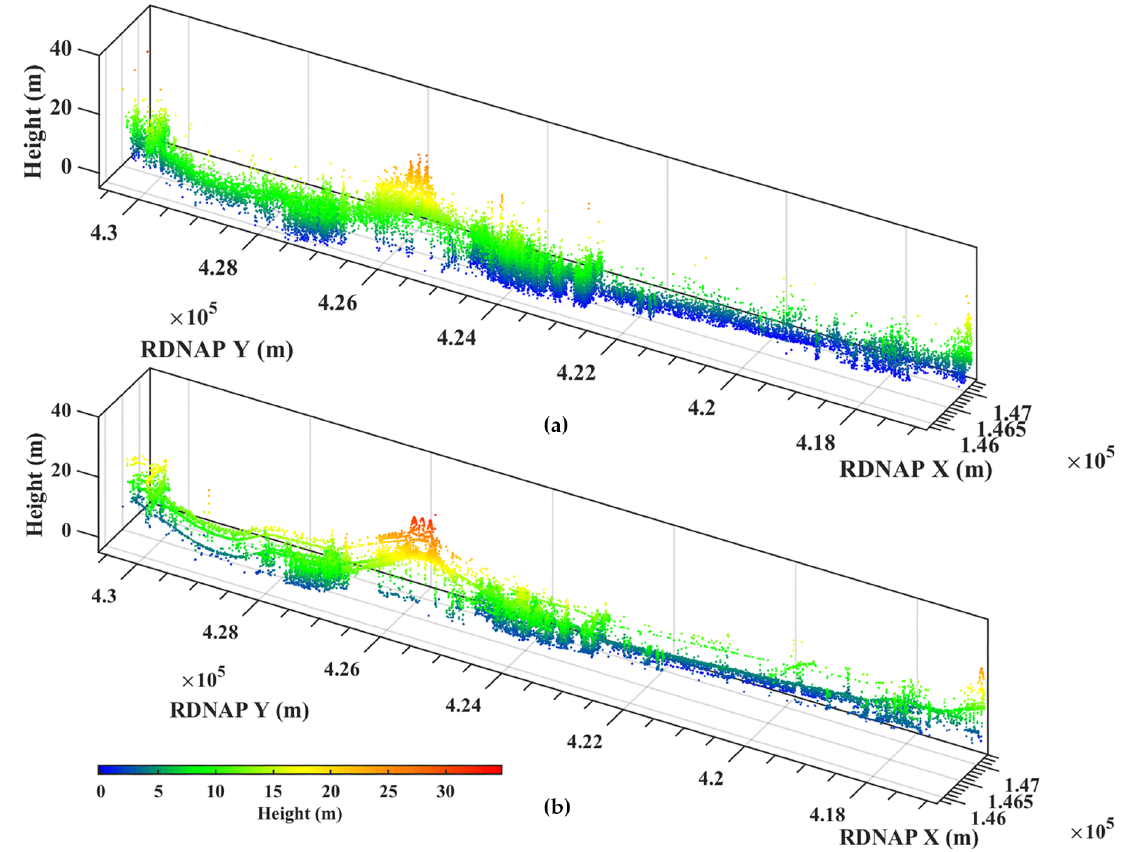
Figure 6. 3D map of radar scatterers ( a ) without and ( b ) with coordinate correction by LiDAR, showing a better separability of high and low objects.